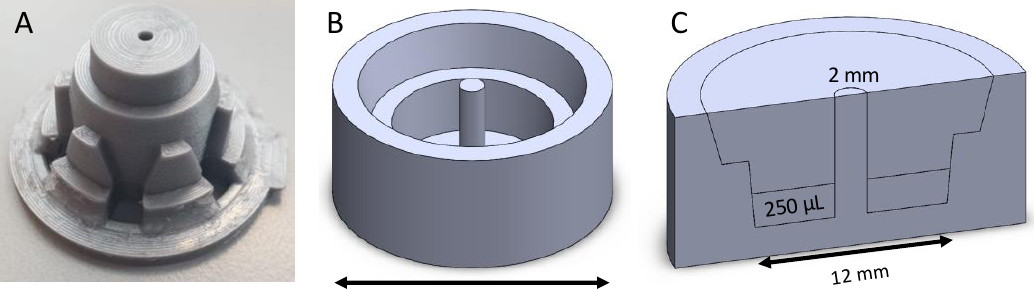
Figure 1. Silicone mold design. Custom made 3D-printed casts to provide the shape for the silicone mold ( A ); The silicone mold had a diameter of 22 mm ( B ); and a centrally placed post 2 mm ( C ). The initial gel volume was 250 μ L and after gelation 500 μ L of the medium was added on top.